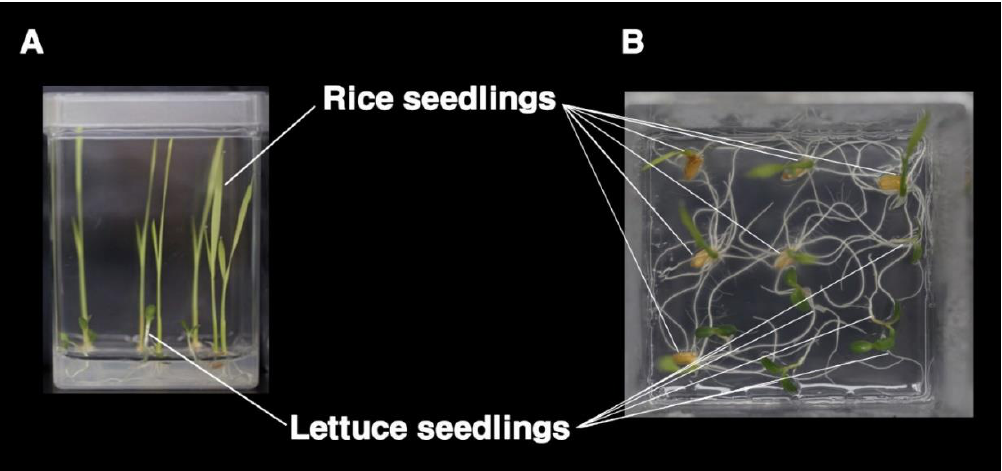
Figure 1. Evacuating method for allelopathic potentials of rice against lettuces seedlings: ( A ) side view of the magenta box where rice seedlings and lettuce seedlings are grown together; ( B ) top view of the magenta box, where rice seedlings and lettuce seedlings are grown together.